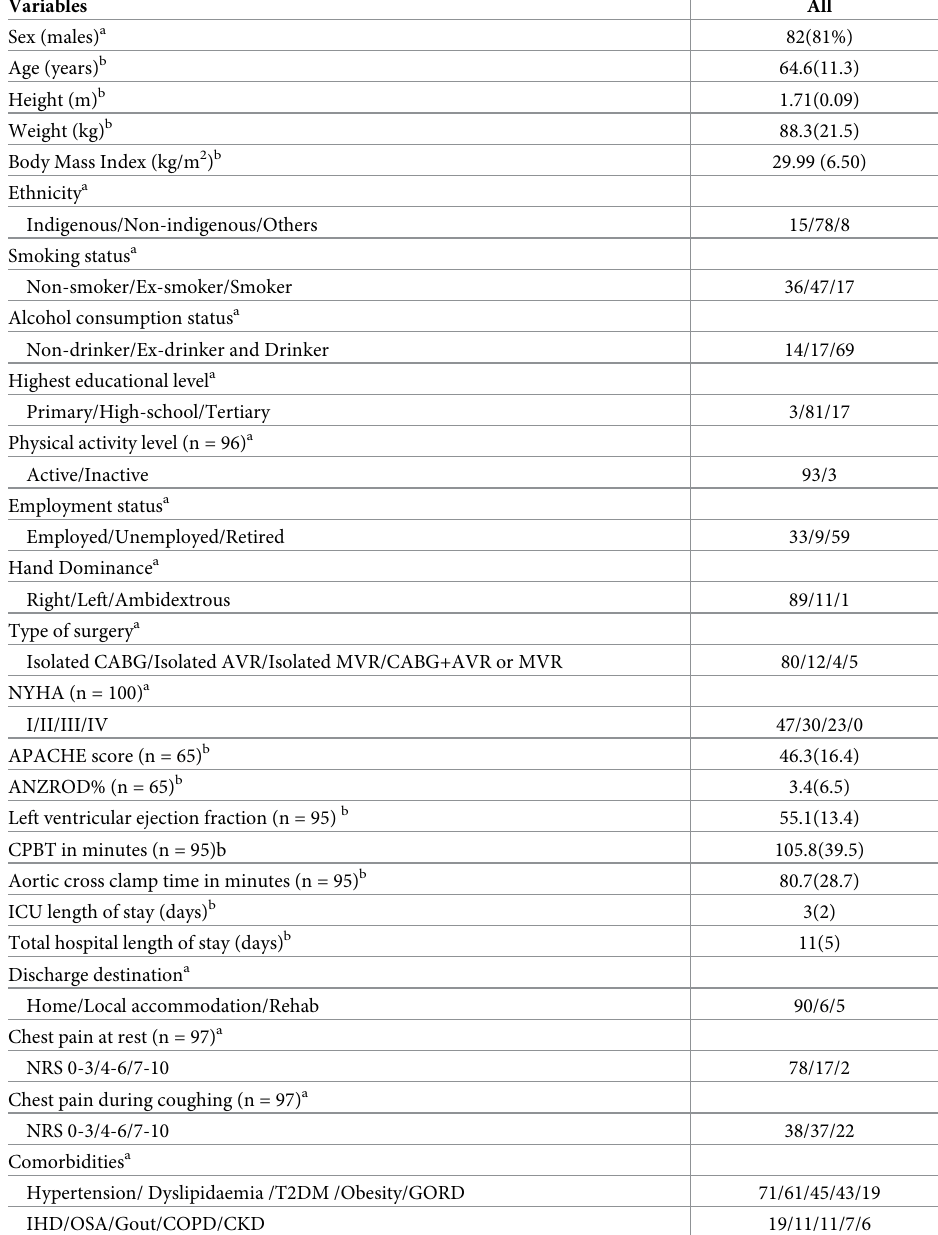
Table 1. Demographic and peri-operative characteristics of participants (n = 101 unless otherwise